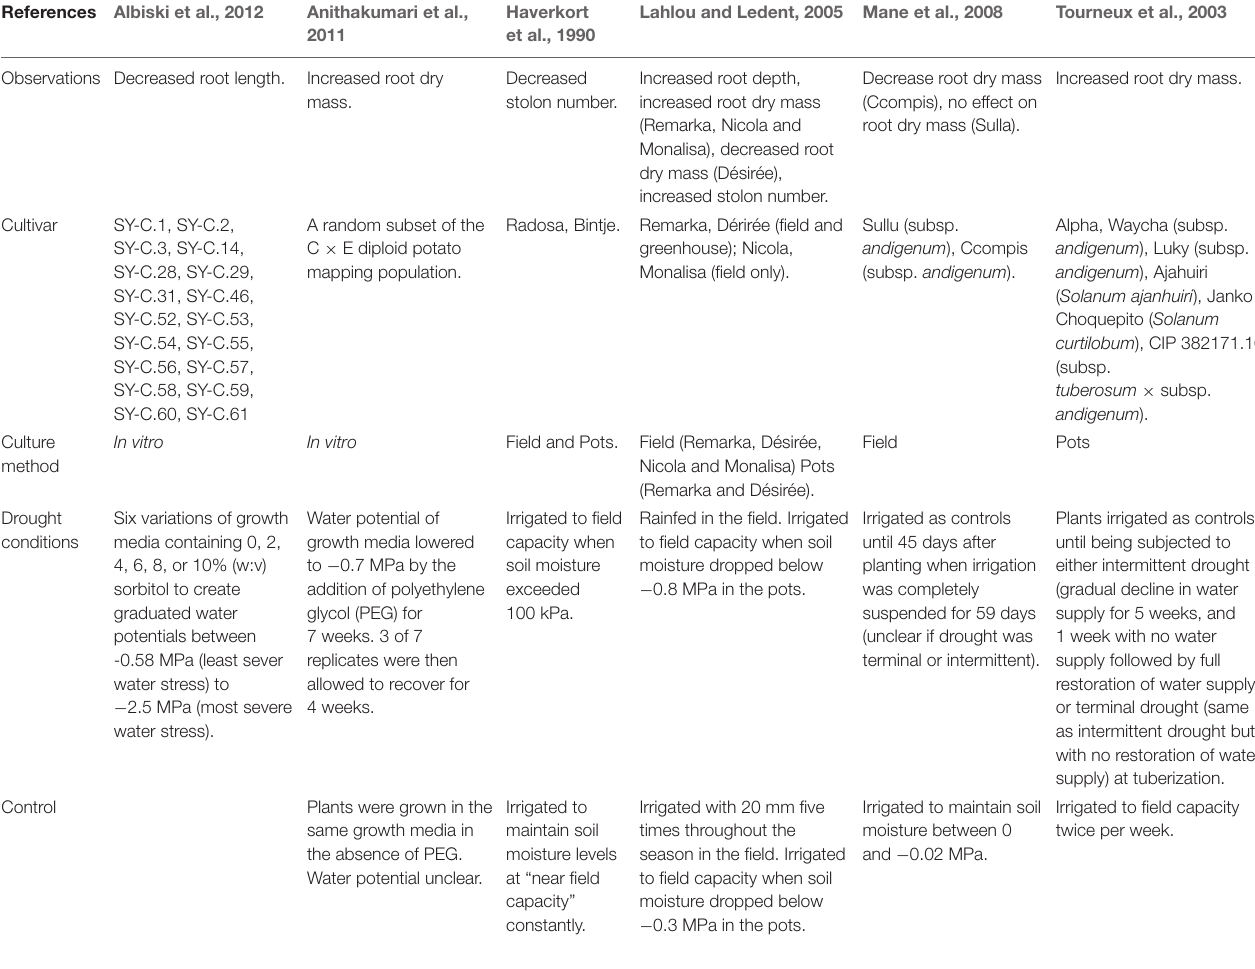
TABLE 1 | A summary of the effects of drought stress on key physiological root traits in potato and the range of methodologies by which these variables were